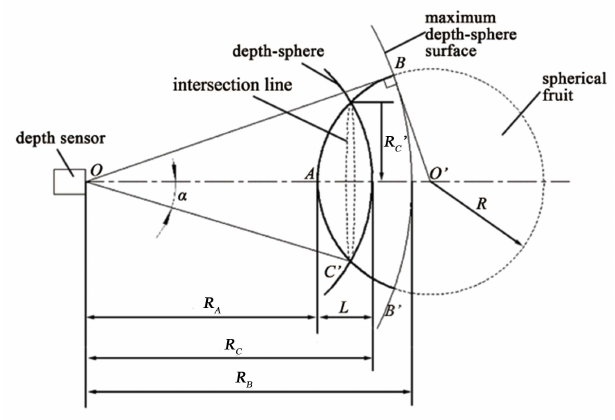
Figure 6. Schematic plan of a spherical entity by depth-sphere